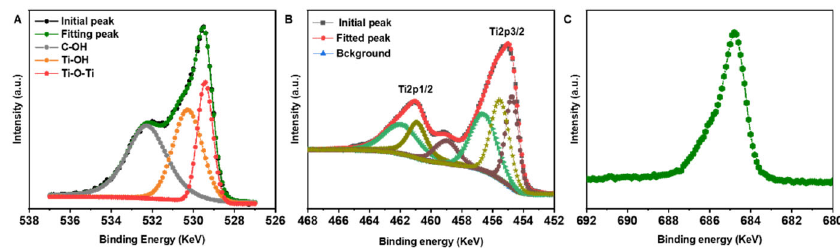
Figure 3. XPS spectra of MXene: ( A ) is O1s, ( B ) is Ti2p, and ( C ) is F1s.